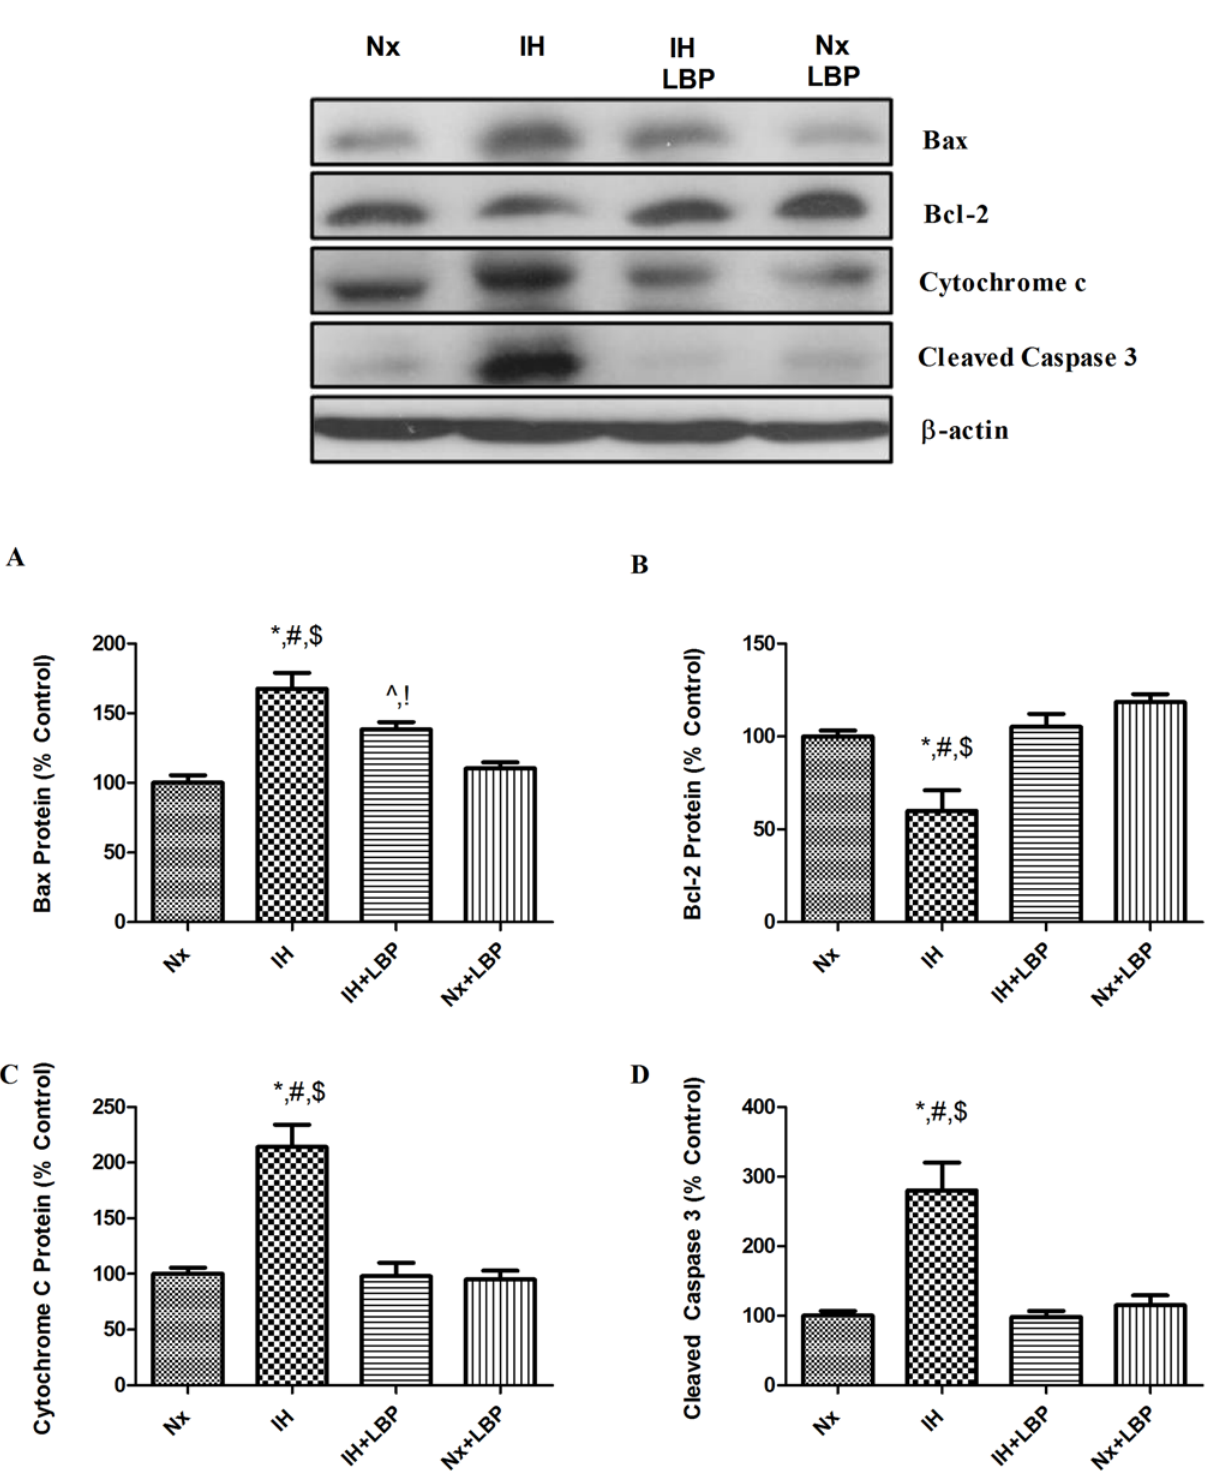
Fig 3. LBP mitigated intrinsic caspase-dependent apoptosis induced by CIH treatment. Levels of the protein expression (upper panel) of (A) Bax, (B) Bcl-2, (C) cytochrome-c and (D) cleaved caspase-3 in the hippocampus of the normoxic (Nx) or hypoxic (IH) groups; LBP-treated hypoxic (IH+LBP) or normoxic (Nx+LBP) groups are summarized. β -actin was an internal control. Data are mean ± SEM (n = 6 – 8). For Bax, * p < 0.05 when compared with Nx, # p < 0.05 when compared with IH+LBP, $ p < 0.05 when compared with Nx+LBP groups, ^ p < 0.05 when compared with Nx, ! p < 0.05 when compared with Nx+LBP. For Bcl-2, cytochrome-c and cleaved caspase 3, * p < 0.05 when compared with Nx, # p < 0.05 when compared with IH+LBP, $ p < 0.05 when compared with Nx+LBP groups.